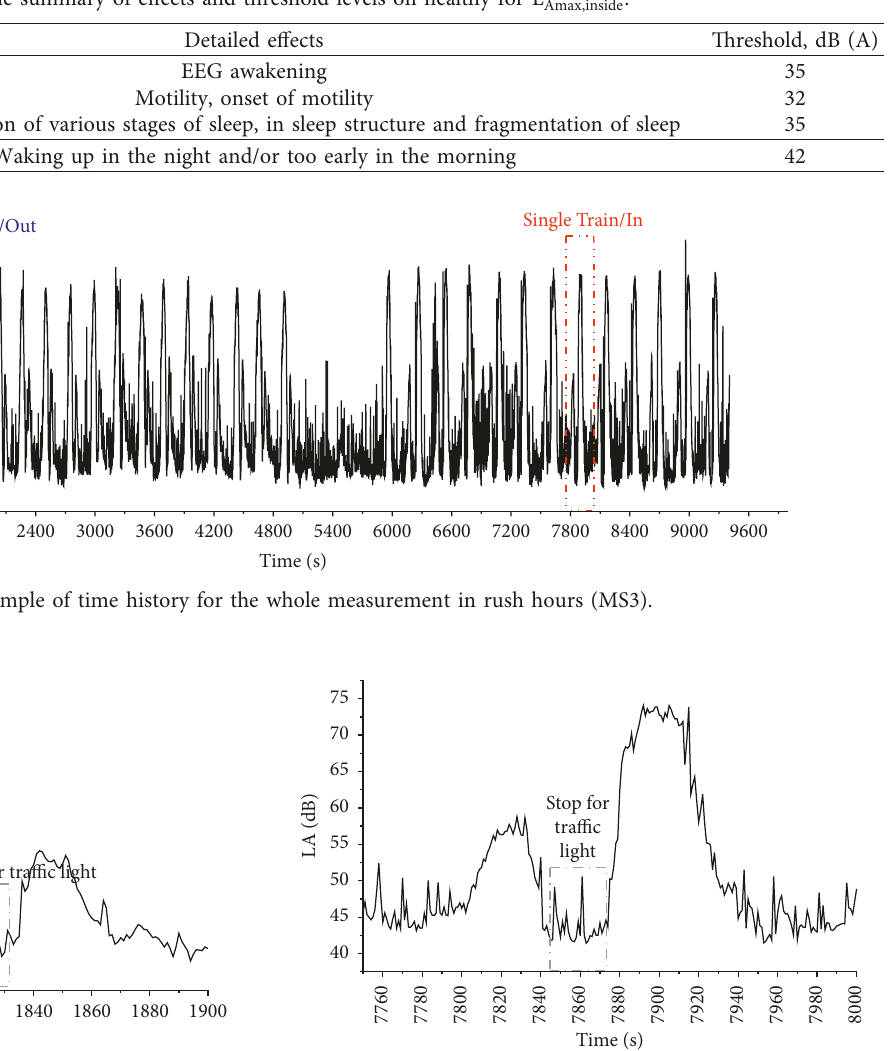
Figure 5: The real photo of sound meters installation at the source. (a) MS1. (b) MS2. (c) MS3. Table 1: The summary of effects and threshold levels on healthy for L